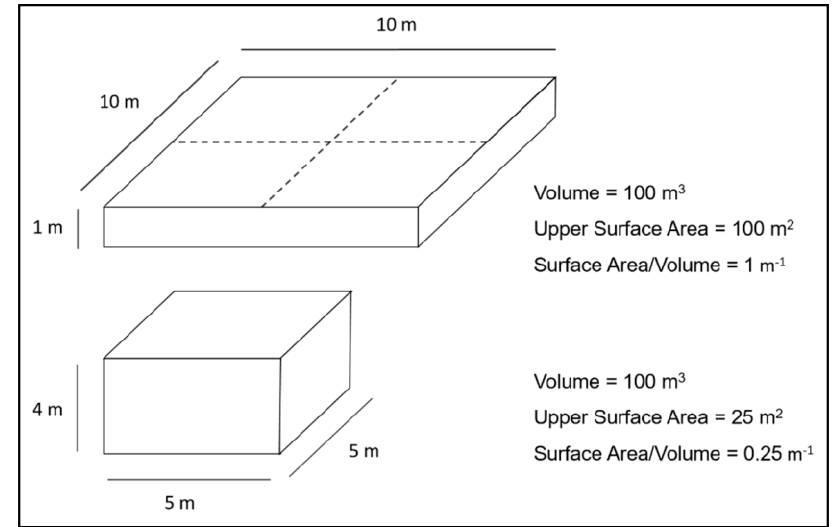
Figure 9. Surface area–volume ratio (after [58]).